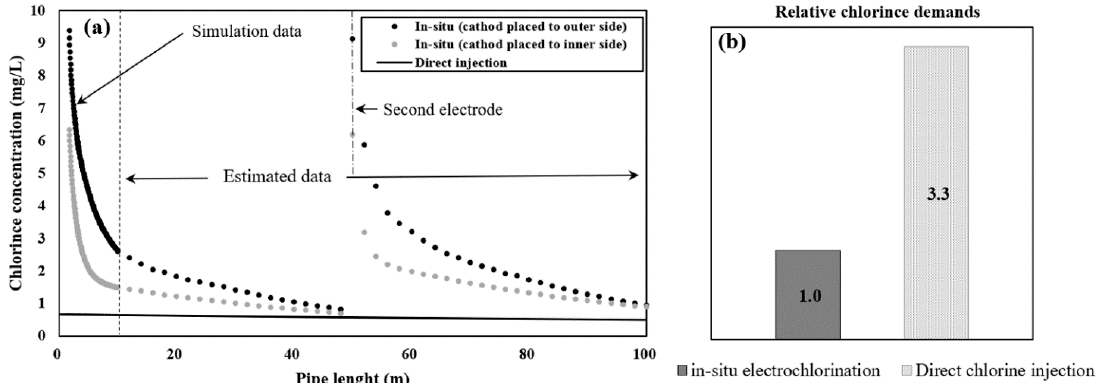
Figure 8. Chlorine concentration contour in the simulation of full-scale in-situ electro-chlorination with di ff erent cathode positions. The pipe diameter is 2 m and the flow rate is 14 m 3 s − 1 . The figure shows 10 m of the pipeline. ( a ) The simulation result when the cathode is placed on the surface of the pipe wall. ( b ) The simulation result when the cathode is placed on the inside of the pipe with 100 mm of distance from the pipe wall.